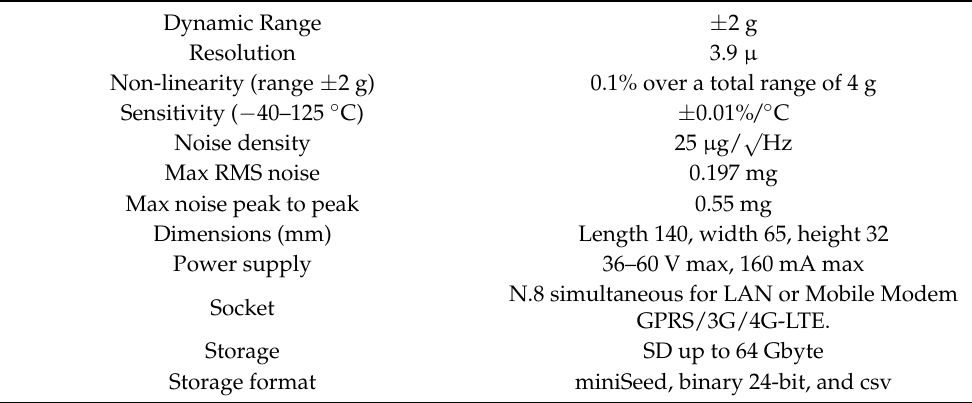
Table 1. Technical specifications of the MEMS Adel prototype ASX1000.